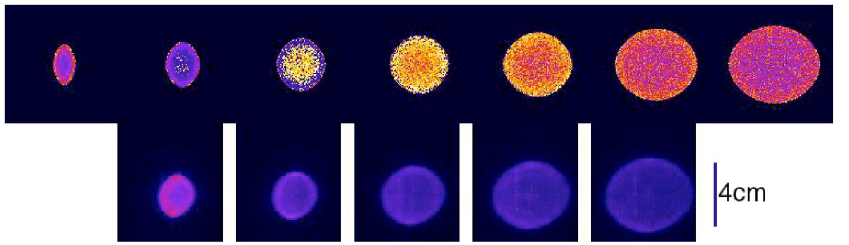
FIG. 36. (Color) Numerical results (top row) and camera images (bottom row) of NTX beam profiles as a function of energy.